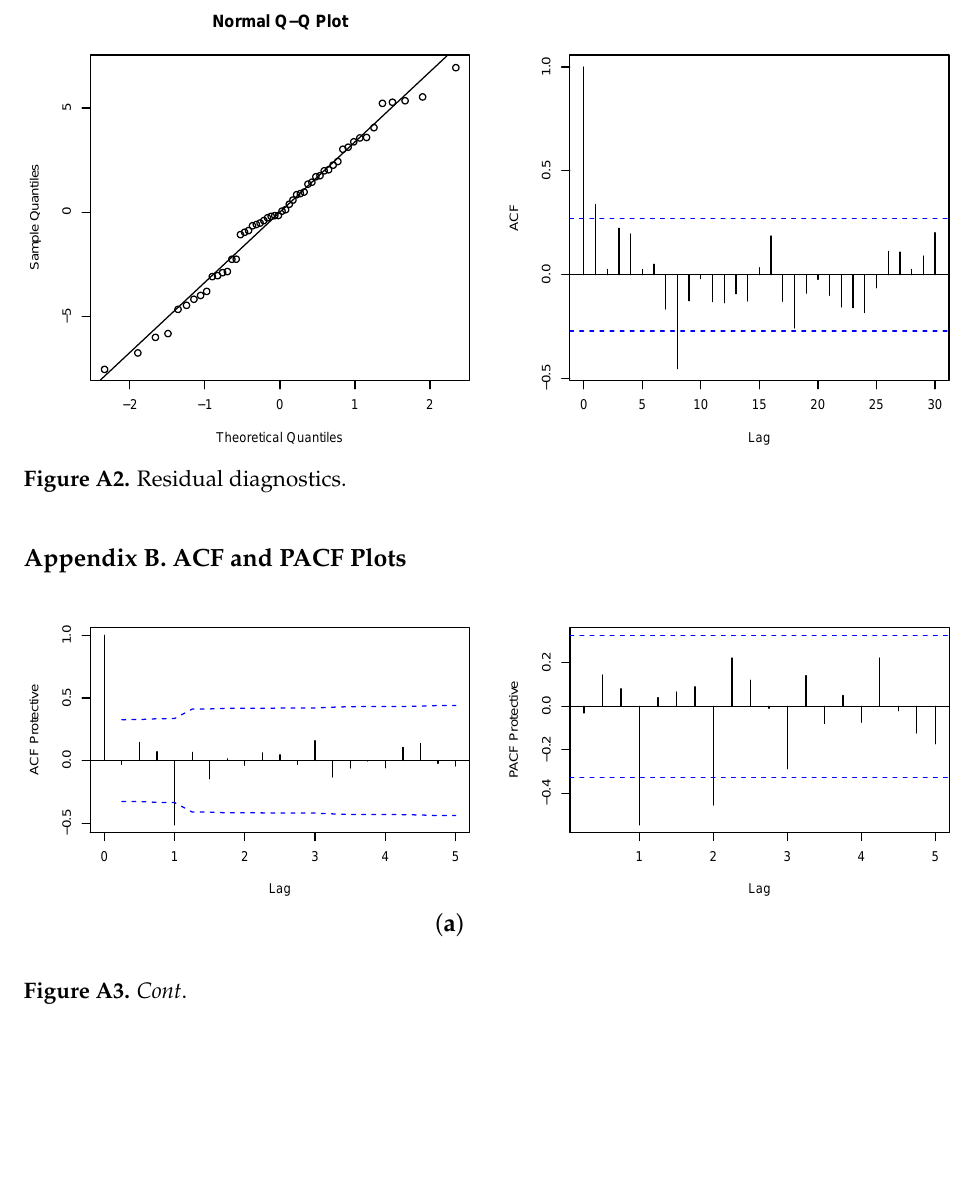
Figure A1. Fitted model.